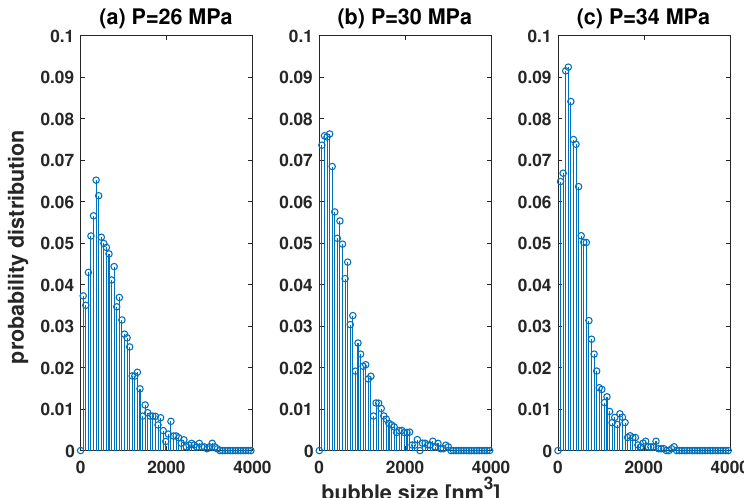
Figure 7. Probability distribution of bubble size with a startup pressure of ( a ) 26 MPa, ( b ) 30 MPa, and ( c ) 34